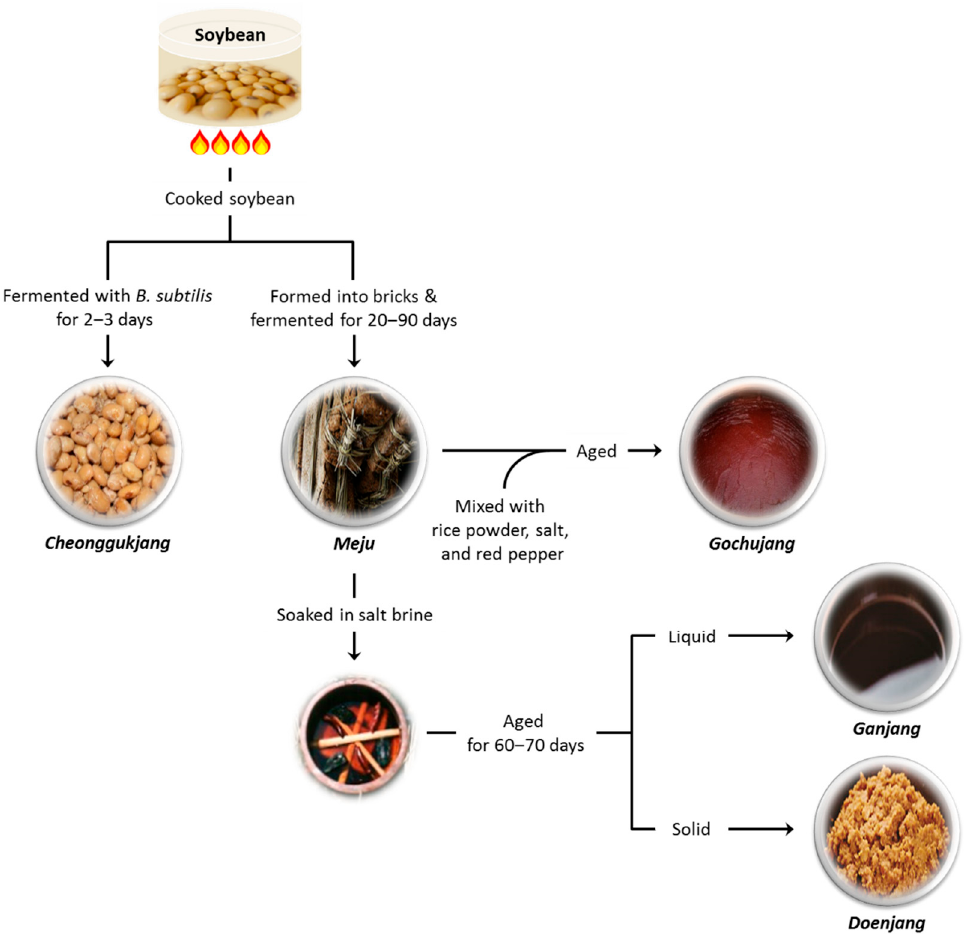
Figure 1. Examples of Korean fermented soy products.